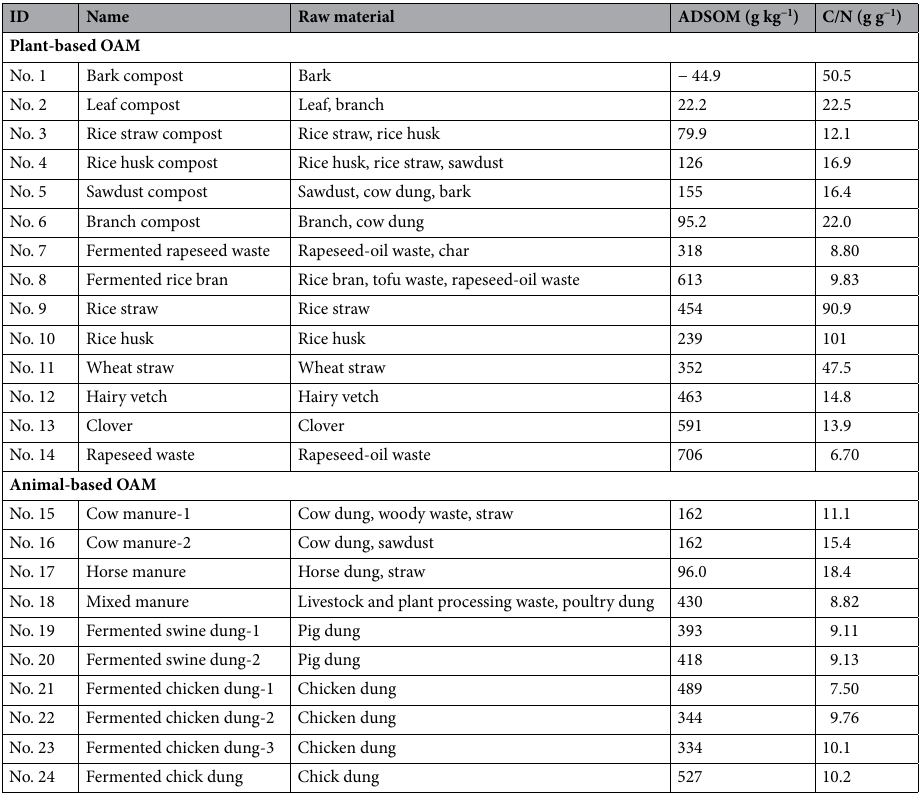
Table 1. Information of examined organic amendments (OAMs) including acid detergent soluble organic matter (ADSOM) and OAM carbon to nitrogen ratio